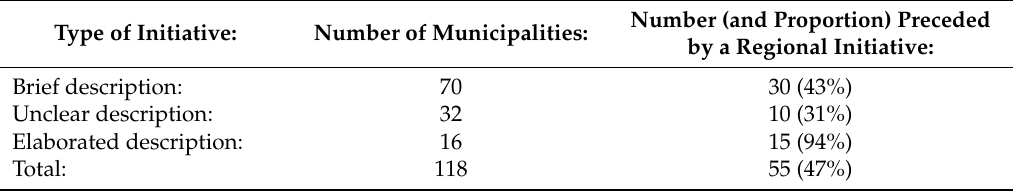
Table 3. Number and percentage of municipal initiatives that were preceded by a regional